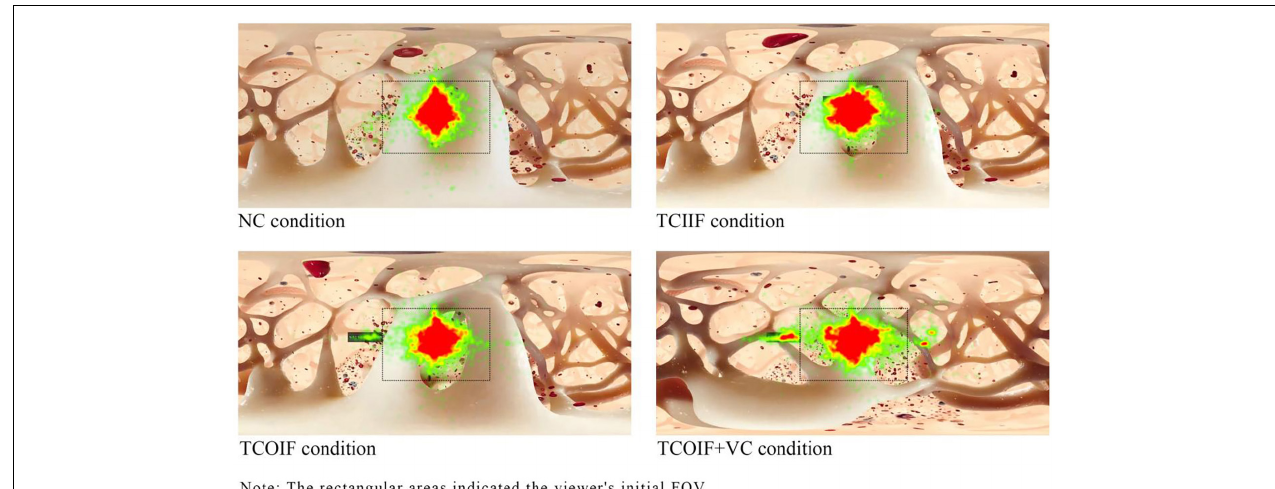
FIGURE 3 | Fixation heatmaps of the four